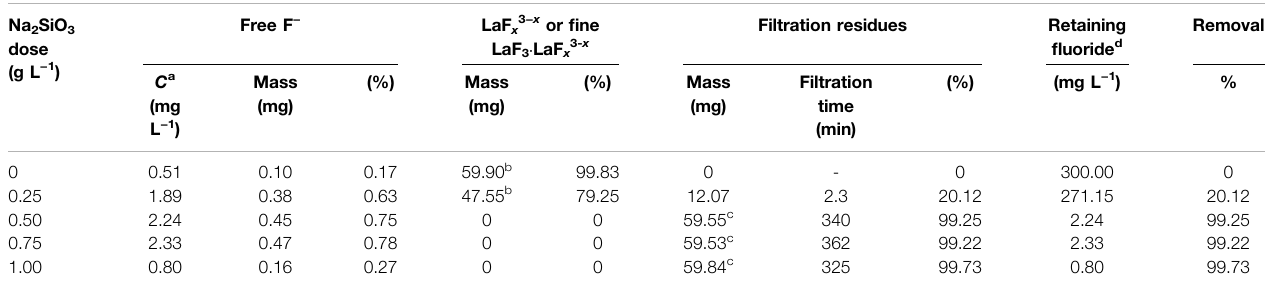
Filtration residues Retaining fl uoride d